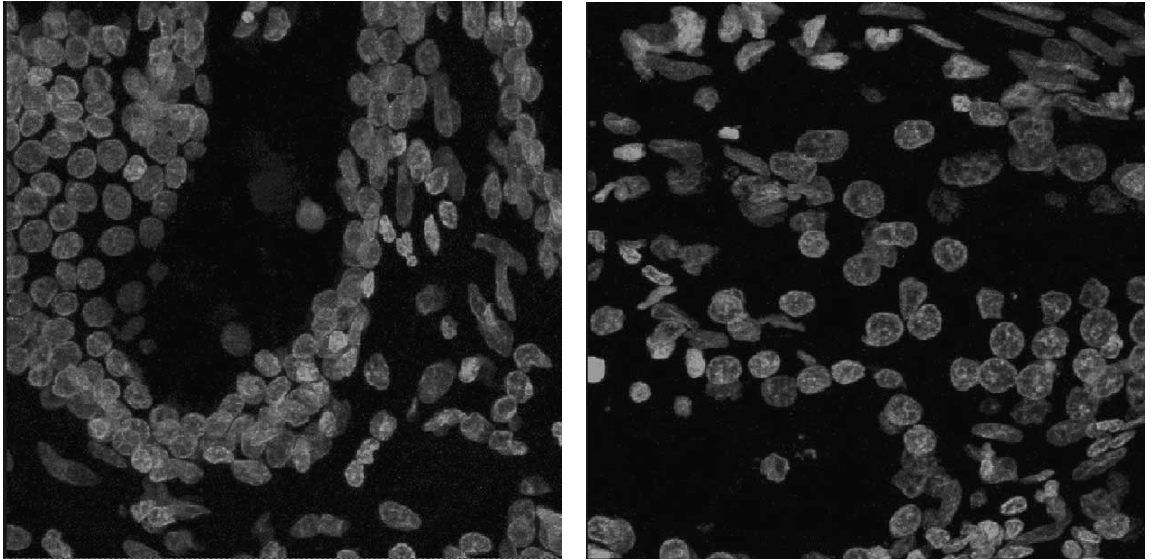
Fig. 1. The transformation of a normal prostate cell nucleus (left) into a malignant cell nucleus (right) is associated with nuclear chromatin changes. For example, the presence of large nucleoli, visible as relatively bright dots in the cell nuclei, are clearly visible in this example. These images are maximum intensity projections from the same confocal image